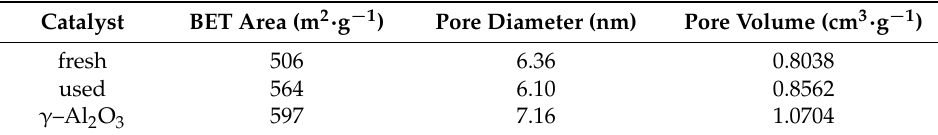
Table 1. Textural characteristics of the fresh and used catalyst.